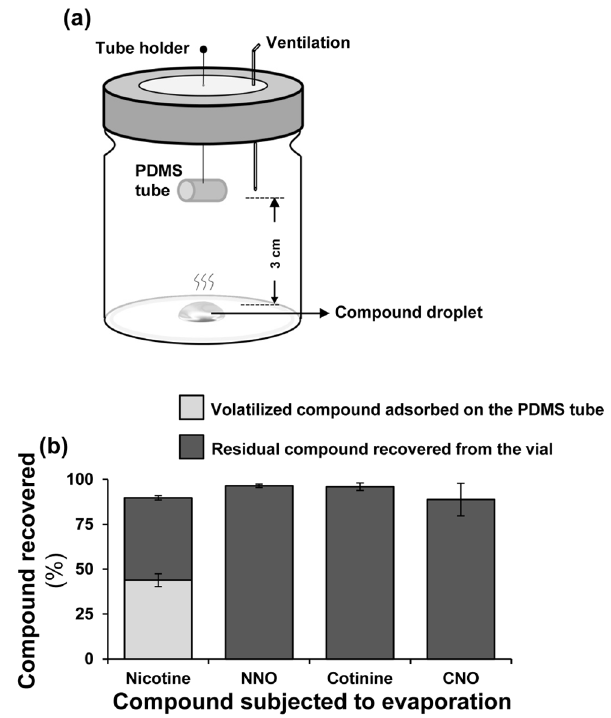
Figure 5. Volatility analysis of nicotine and nicotine oxides. ( a ) Schematic of setup used for the collection of evaporated nicotine, NNO, cotinine and CNO placed in the collection vial (1 m g/5 m L methanol). ( b ) Percentage of evaporated and residual nicotine, NNO, cotinine and CNO (n=4); one m g of nicotine, NNO, cotinine or CNO (in 5 m L methanol) was incubated for 1 h.